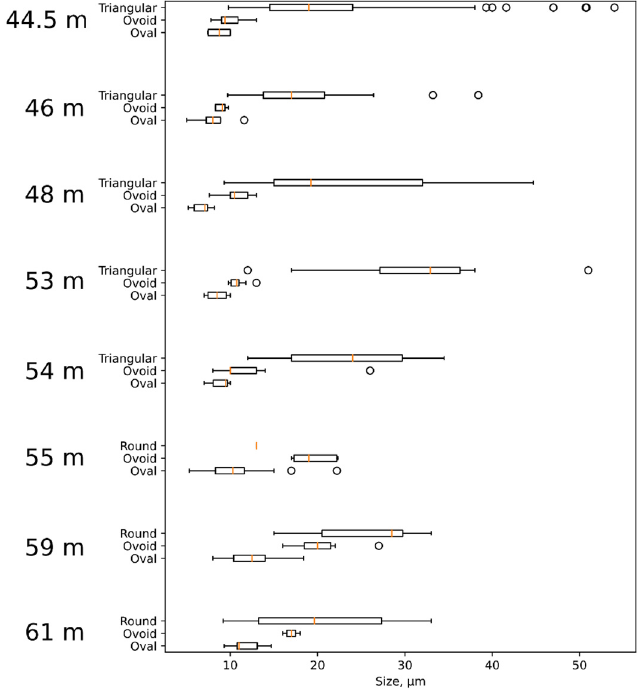
Figure 6. The distribution of Alveolophora antiqua valves of different shapes by size in core 517. For round valves, we measured the diameter; for oval ones—larger diameter; for triangular ones—a valve.